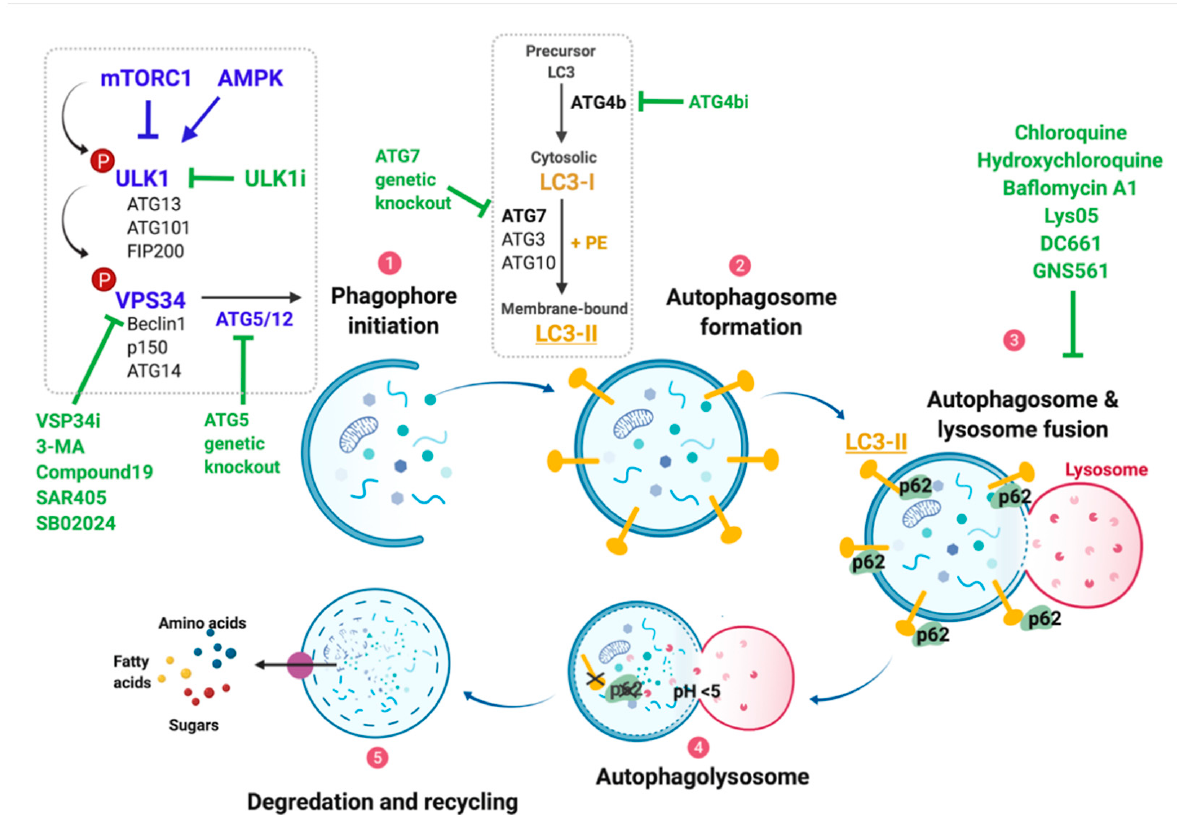
Figure 2. The autophagy machinery and targetable autophagic pathway proteins. Autophagy is a metabolic process of cellular self-digestion in which cellular components, such as abnormal protein aggregates and damaged organelles, serve as recycling substrates in order to generate energy or metabolic precursors, often in response to external stress. The process starts with phagophore initiation, which is regulated by ULK1 and VPS34 complexes, which can be blocked by selective inhibitors, as indicated, as well as ATG activity, resulting in the initiation and elongation of the phagophore membrane. Processing of LC3 by ATG4b as well as several ATGs leads to maturation and finally completion of the autophagosome. The autophagosome then fuses with the lysosome, a step that can be pharmacologically blocked with chloroquine or other compounds, as indicated. In the resulting autophagolysosome, the pH drops to <5, leading to degradation of its collected compo- nents.